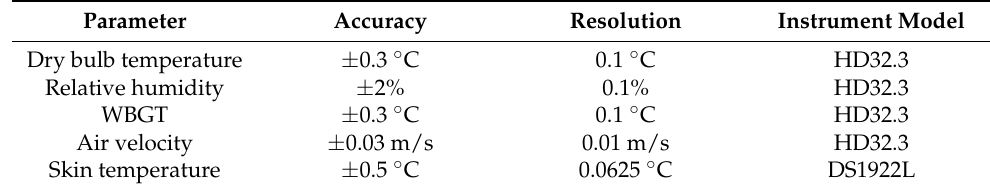
Table 2. Information of data acquisition devices.